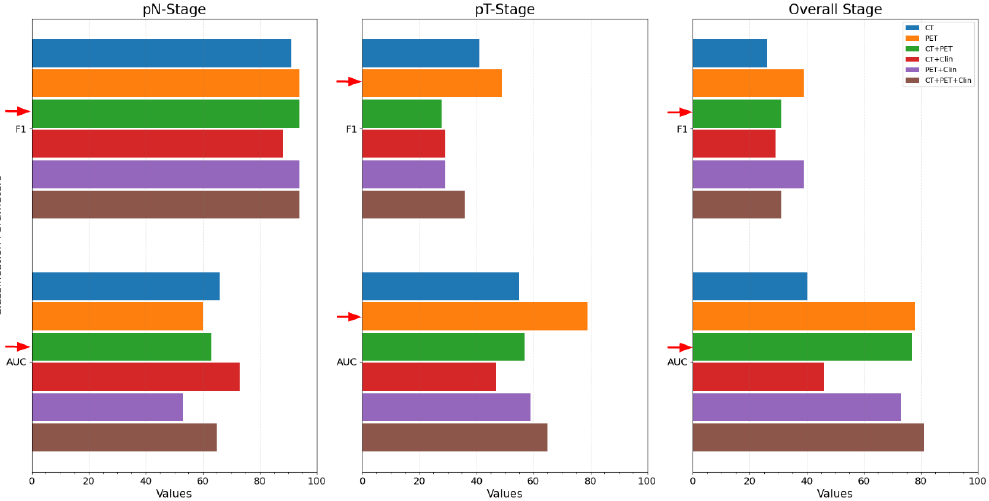
Figure 5. Radiomics features extracted from the LoG-filtered PET and CT images. The red arrows indicate the best results obtained by using the best model in terms of AUC for LOO-CV strategy on DS 1 . The bar-plot refers to all possible combinations between the features, to obtain higher classification performance (F1 score and AUC), pN-Stage (12 features from CT images and 21 features from PET images), pT-Stage (2 features from PET images) and the Overall Stage (20 features from CT images and 18 features from PET